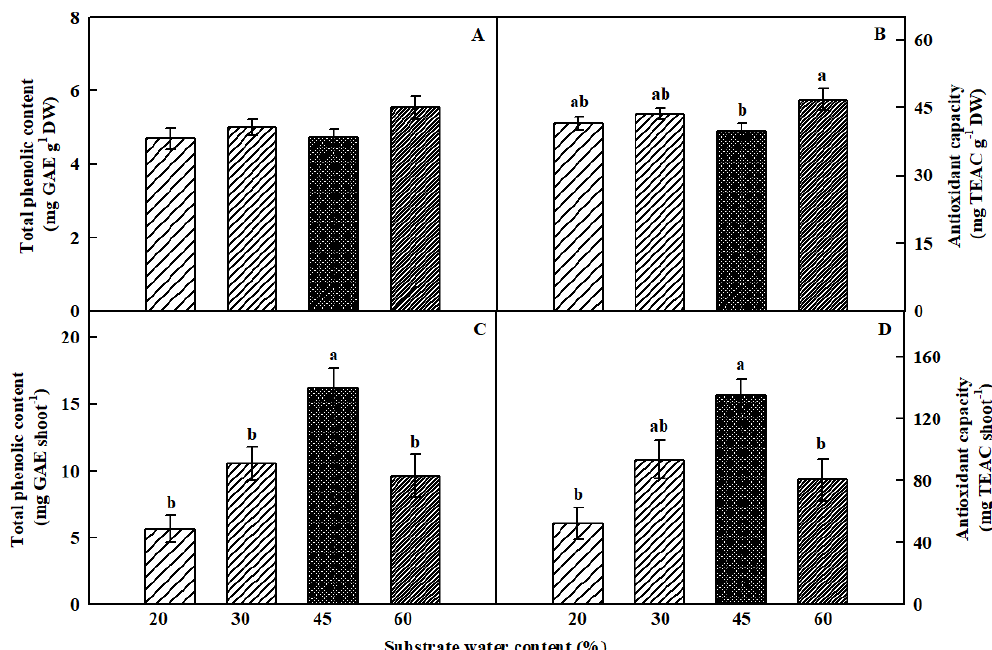
Figure 6. Effect of substrate water content on phenolic content and antioxidant capacity: Total phenolic content and antioxidant capacity per unit dry weight ( A and C ) and per shoot ( B and D ) of Crepidiastrum denticulatum grown under four different substrate water content levels for 5 weeks. The data indicate the means ± S.E. ( n = 12). Di ff erent letters above the bars indicate statistical di ff erence by Tukey’s Studentized Range Test at p < 0.05.